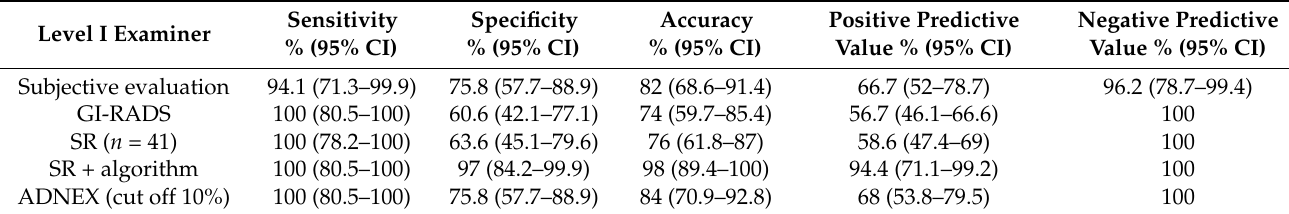
Table 3. Diagnostic performance of models based on resident’s (level I) evaluation.